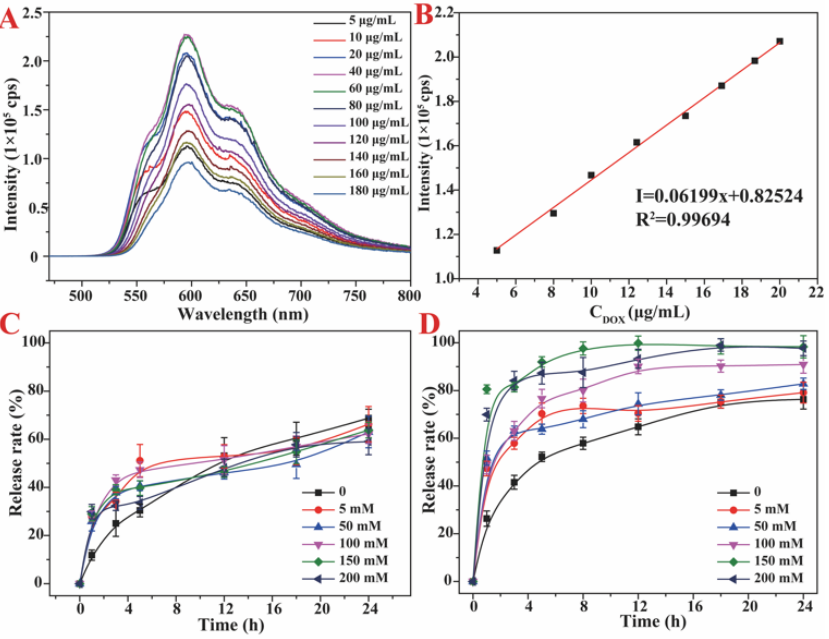
Figure 7. The fluorescence vs. concentration curves of DOX ( A ) and its standard fluorescence curve ( B ), release curves of PLENB3 drug-loaded micelles under different K + concentrations and different environmental temperature: room temperature ( C ) and 37 °C ( D ).